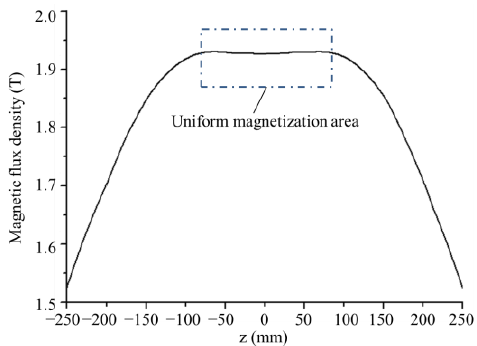
Figure 2. The axial magnetic flux density distribution in the drill pipe wall.